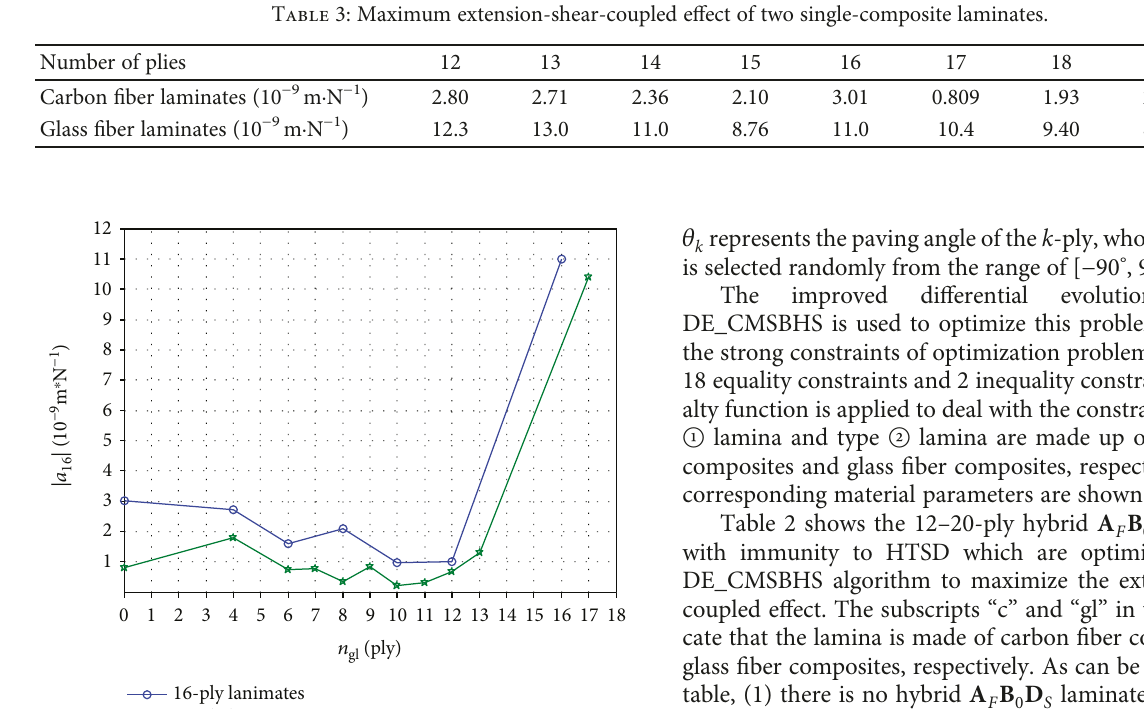
Table 2: Hybrid A